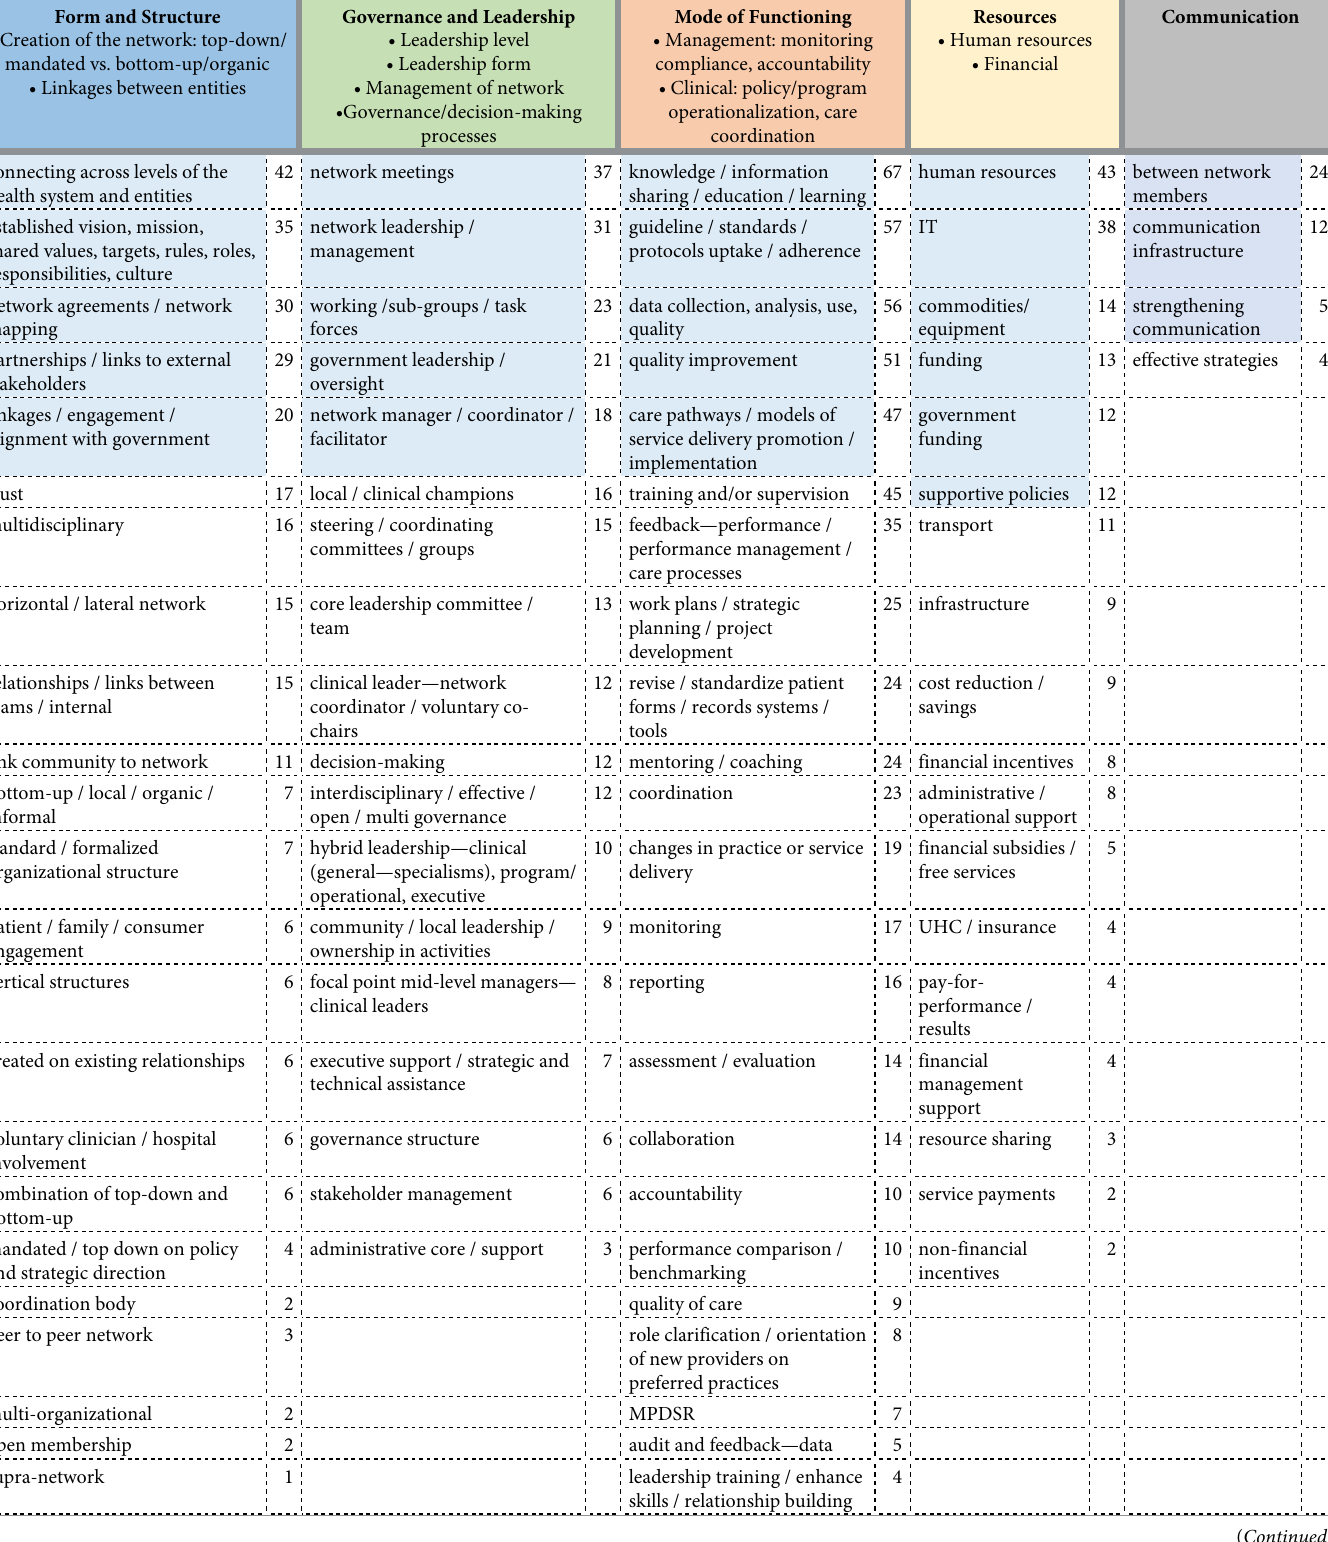
Table 3. Network components with corresponding practical characteristics. The number of references in the selected literature are shown for each characteristic. Form and Structure • Creation of the network: